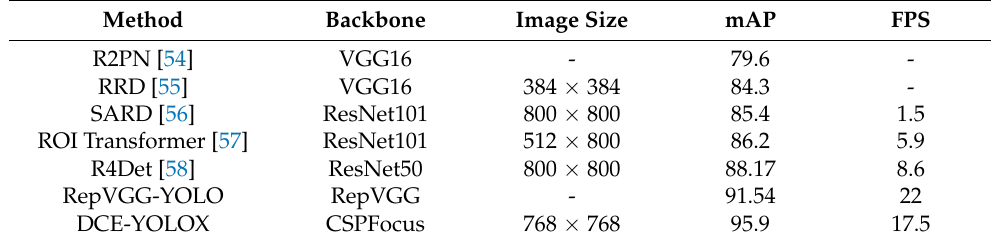
Table 6. Detection results of HRSC2016 dataset.